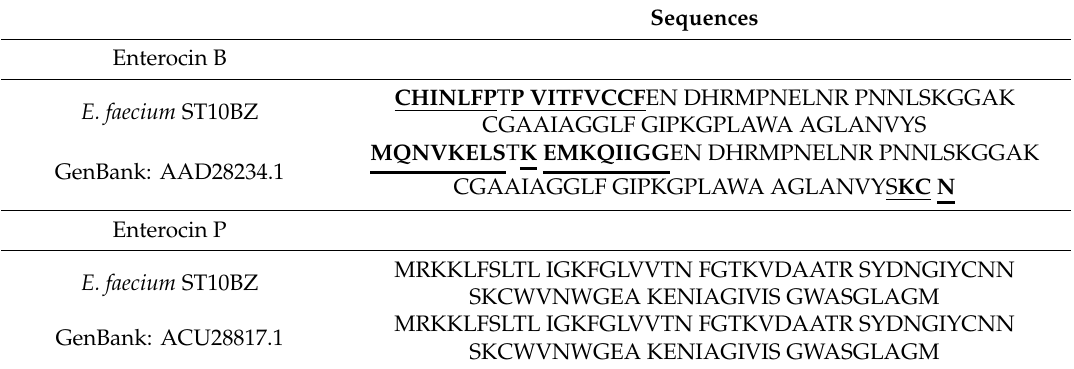
Table 2. The putative protein sequences of enterocins B and P generated from the nucleotide sequence of the amplicons; results of the PCR targeting appropriate bacteriocin genes in the genome of E. faecium ST10Bz in comparison to that of known enterocins B and P. Di ff erences in amino acids are indicated in bold and